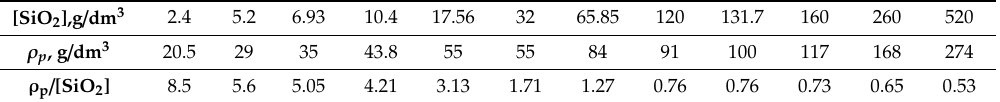
Figure 7. TEM images of SiO 2 nanopowder particles obtained by tunneling electron microscopy. Dimensions of the image area of SiO 2 particles: ( a ) 212 × 212 nm 2 ; ( b ) 88 × 88 nm 2 ; ( c ) 52 × 52 nm 2 . Table 2. Pour density of nanopowders, ρ p , depending on the SiO 2 content in the